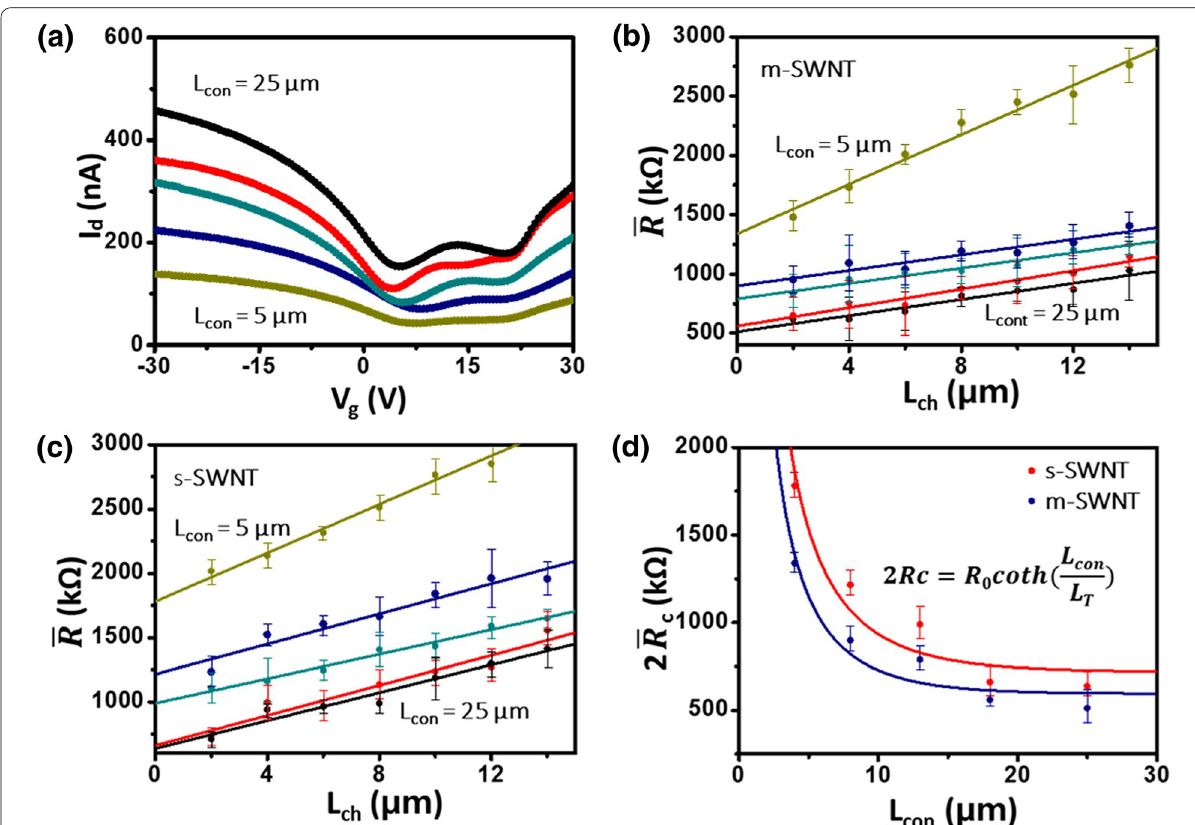
Fig. 4 a I d –V g transfer characteristics of graphene-SWCNT TFT with different L con (5, 10, 15, 20, 25, 30 μm) and a 10 μm channel width. The average resistance of the m-SWCNTs ( b ) and s-SWCNT ( c ) as a function of L ch at different L con . d The extracted contact resistance as a function of L con and fitting